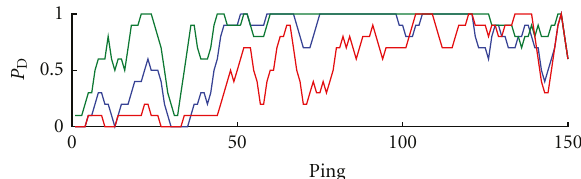
Figure 11: Target P D for RX1 (blue), RX2 (green), and RX3 (red), respectively; The P D is averaged over 5 pings and over FM and CW. Detection performance of receivers RX1 and RX3 is poor for the first 50 pings due to the large distance to the target.